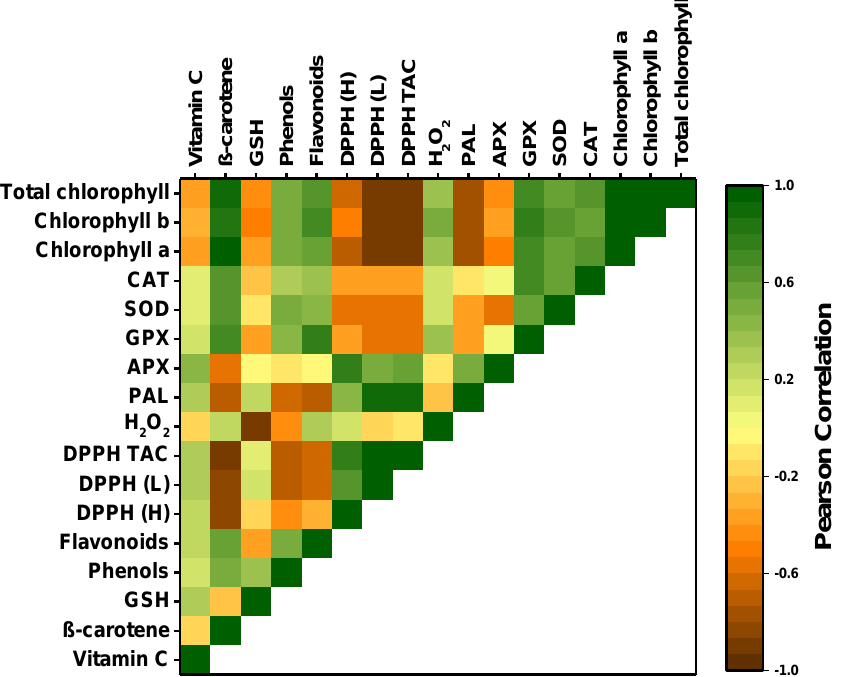
Figure 7. The Pearson correlations of antioxidant variables determined in the leaves of tomato seedlings treated with carbon nanomaterials.